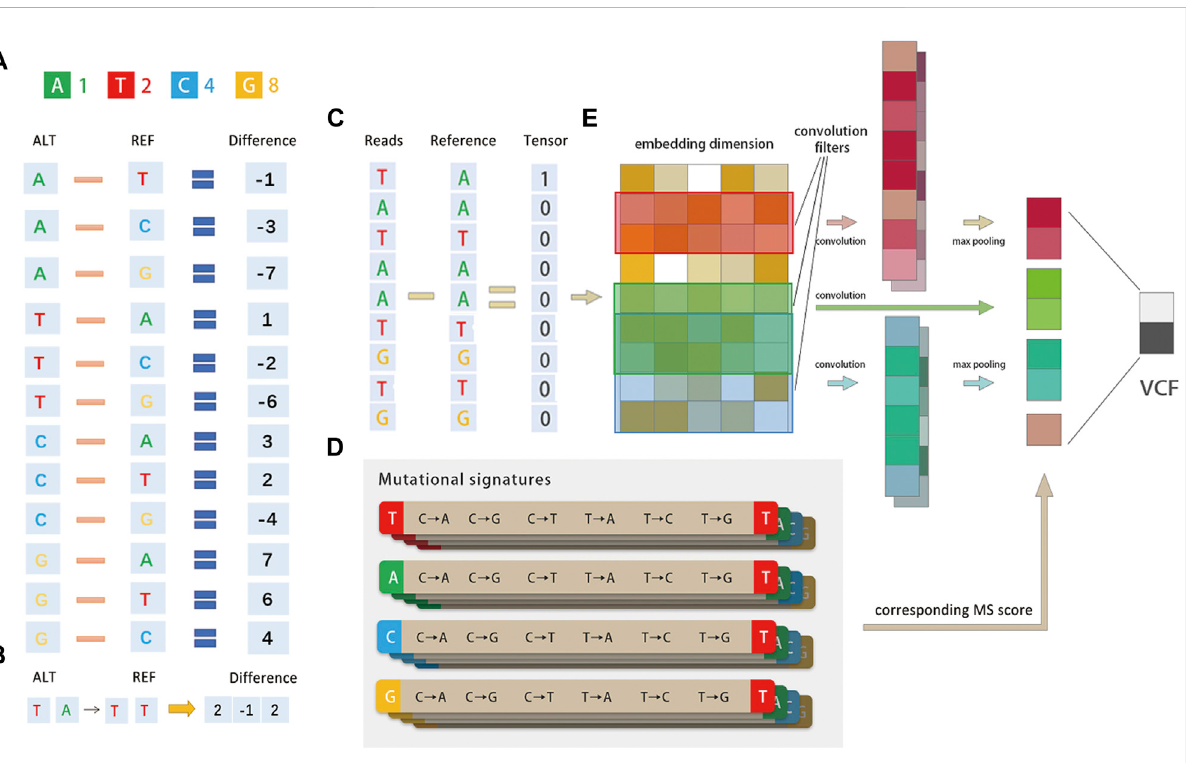
FIGURE 2 Methoddiagram. (A) Diagrammaticrepresentationofthebase difference.BasesA/T/C/Gareconvertedto1/2/4/8 codes andforeachread,and the difference between it and the corresponding position of the built-in reference is calculated. The mutational signature is encoded by tri- nucleotide structure, for example, if a position is A → T, the corresponding position is encoded as 1 – 2 = − 1. (B) Representation of the tri-nucleotide structure of the mutational signature. The mutational signature is encoded by tri-nucleotide structure; if a position has T (A → T) T, the corresponding position is encoded as (2, − 1, 2). (C) Schematic representation of the entire pipeline. The network structure consists of three convolution fi lters, each followed by a ReLU layer. The mutational signature probabilities are concatenated before the Softmax layer. The output is the true SNV with false positives fi ltered. (D) There are 96 possible mutations as we incorporated six classes of base substitution: C > A, C > G, C > T, T > A, T > C, and T > G (referred by a pyramiding of mutated Watson – Crick base pair) and base information for the 5 ′ and 3 ′ bases immediately adjacenttoeachmutatedbase. (E) DETexTconvertsthereadsofthevariancerepresentation (C) intotheembedding_sizedimension (E) throughthe embedding operation of the